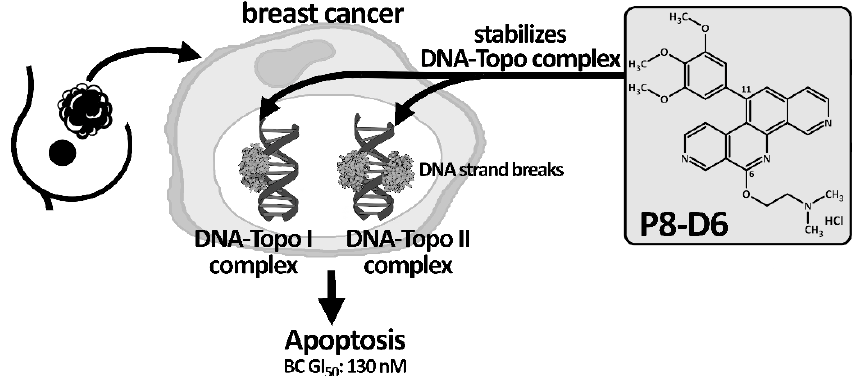
Figure 1. Schematic mechanism action of P8-D6. As a topo I/II poison, P8-D6 covalently stabilizes the enzyme–DNA complex and, thus, increases the amount of single- and double-strand DNA breaks and subsequently causes cell death. Initially, effectiveness and the broad activity spectrum of P8-D6 was verified in the NCI-60 DTP human tumour cell line screening by the NCI. P8-D6 was able to induce a 50 % growth inhibition in 60 cell lines in nanomolar concentrations (49 nM) [4]. In BC cells, P8-D6 reached an average GI 50 (BC) value of 130 nM. GI 50 (BC): average growth inhibition of 50% in BC cell lines.